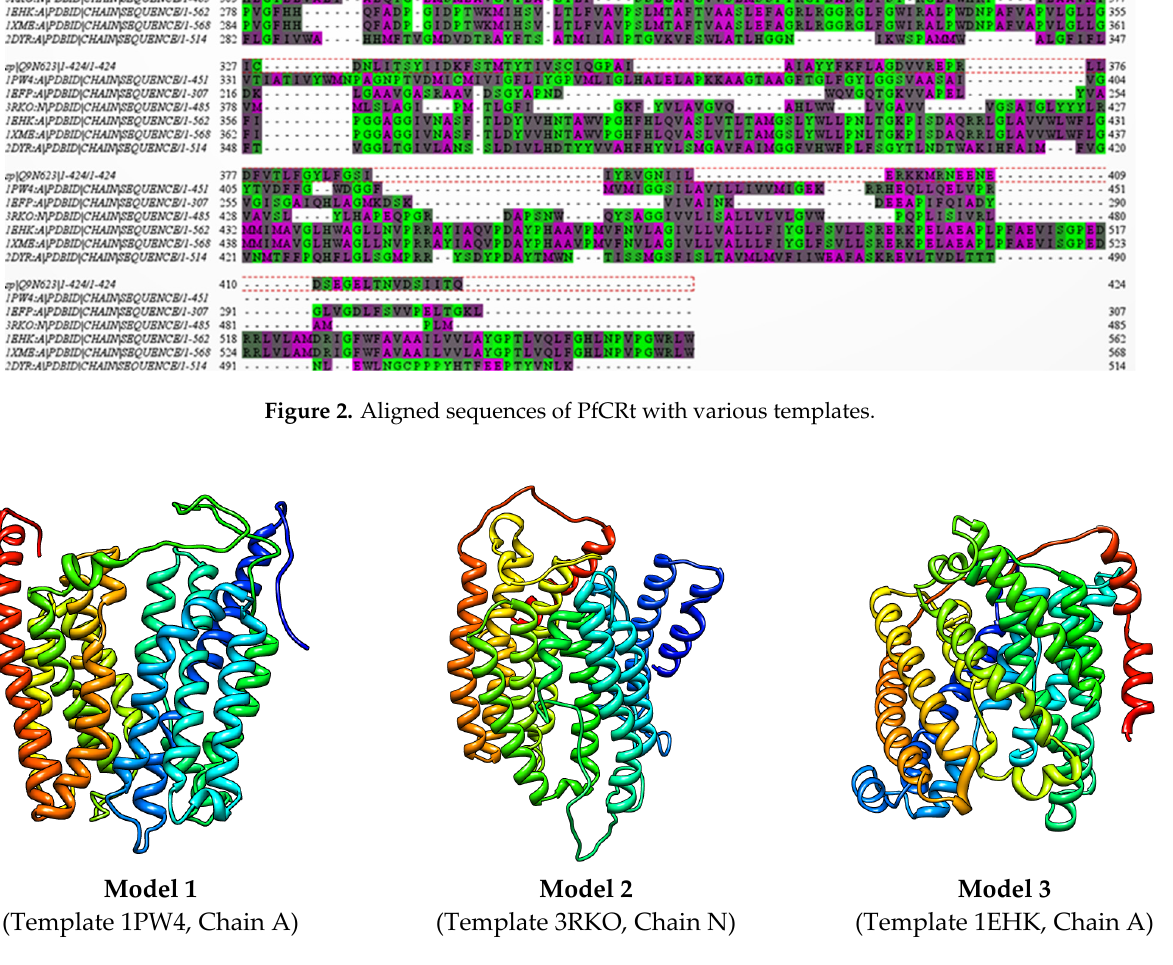
Table 1. Template hits obtained from pGenThreader analysis.